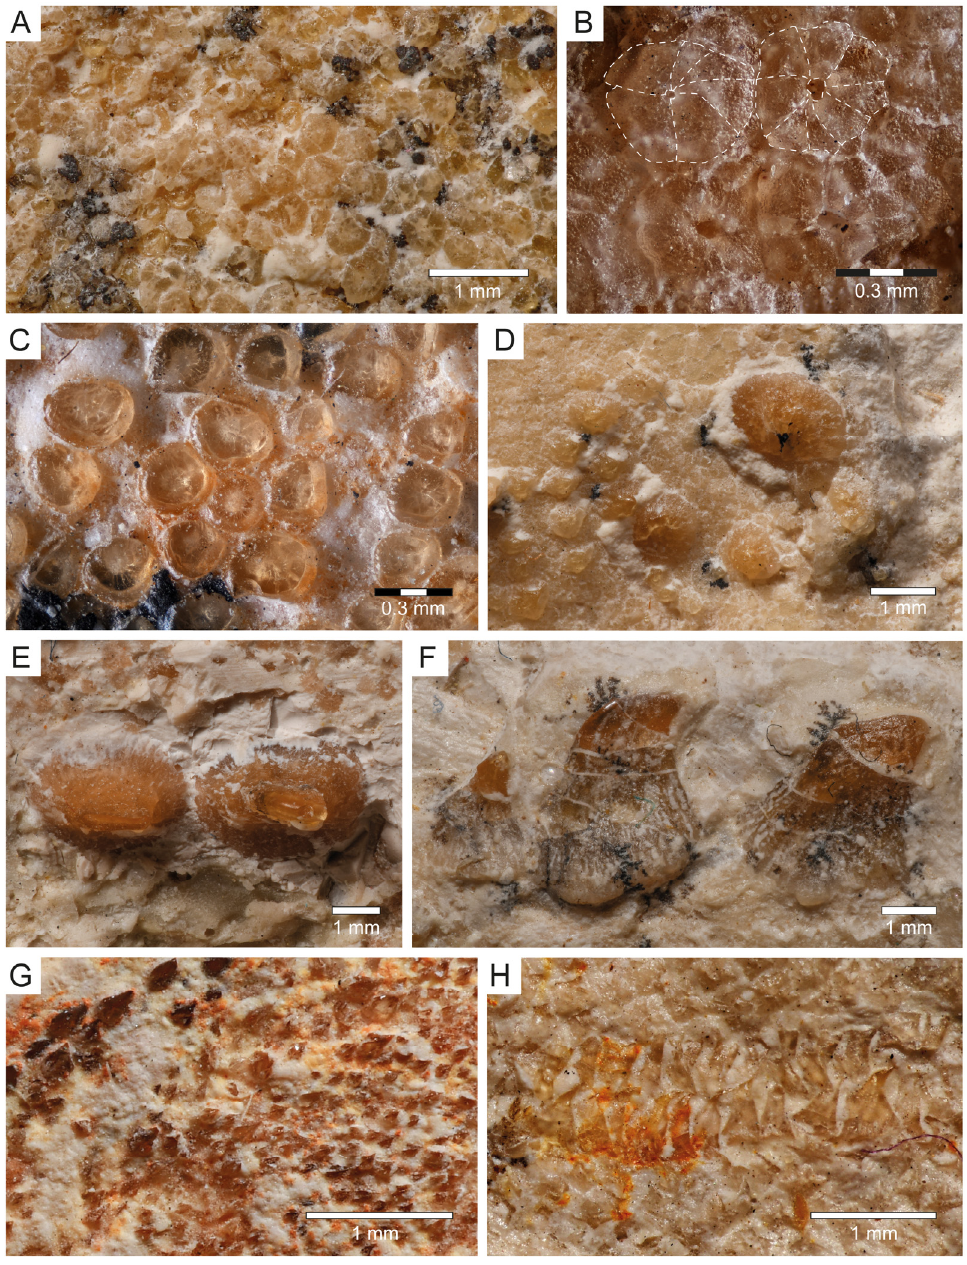
Figure 8. Dermal denticles of Protospinax annectans Woodward, 1918, PBP-SOL-8007, from the lower Tithonian of the Solnhofen Archipelago, Bavaria, Germany. ( A ) Morphotype 1; ( B ) close-up view of morphotype 1; ( C ) morphotype 2; ( D ) enlarged dermal denticles (morphotype 3) in front of the orbital region; ( E ) enlarged dermal denticles (morphotype 3) from the dorsal midline of the trunk in dorsal view; ( F ) enlarged dermal denticles (morphotype 3) from the dorsal midline of the trunk in lateral view; ( G ) morphotype 4; ( H ) C-shaped ringlets of the lateral line organ. The regions of the body, where the different morphotypes were extracted are summarized in Figure 3A.